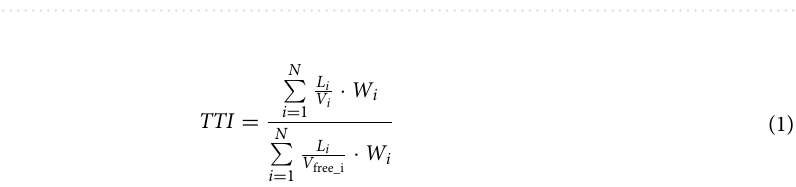
Figure 1. Light gradient hoist histogram algorithm